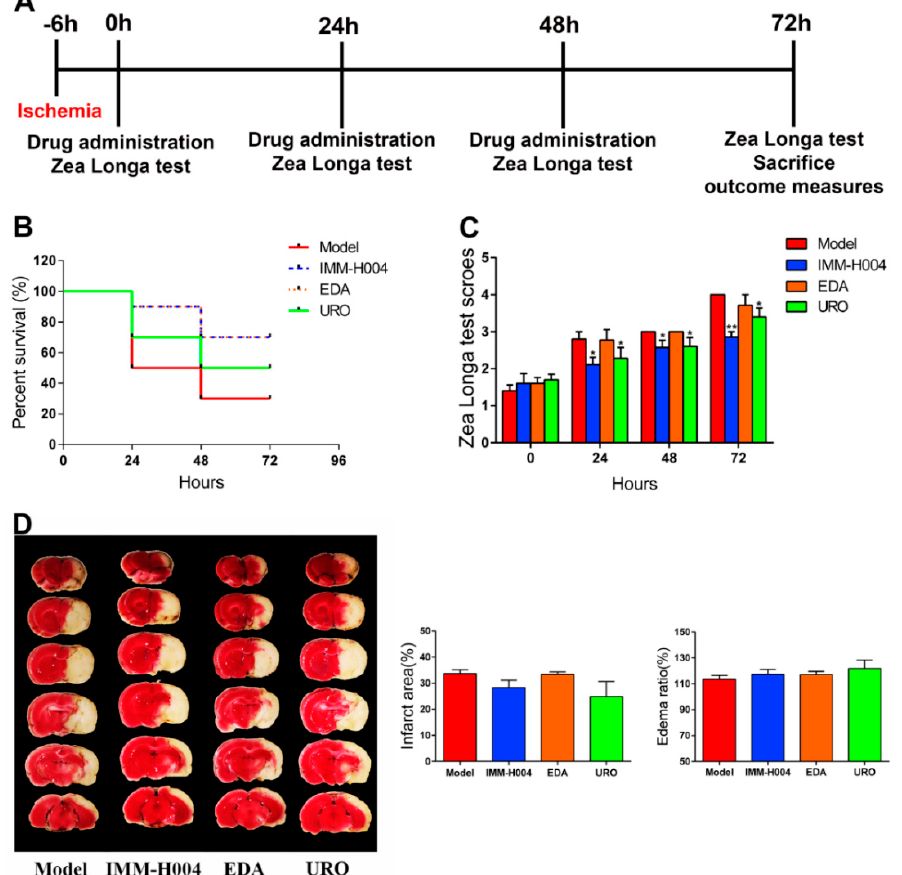
Figure 3. Successive administration of IMM-H004 once daily for three days protects against Permanent focal cerebral ischemia-induced brain injury in adult rats. ( A ) The timeline diagram of successive administration of IMM-H004 once daily for three days. ( B ) Statistical analysis of the 72 h survival rate. ( C ) Statistical analysis of Zea Longa test scores. ( D ) Representative images of TTC staining, and analysis of infarction area and edema ratio. Data are shown as the mean ± SD ( n = 10/group). * p < 0.05 vs. model; ** p < 0.01 vs. model.